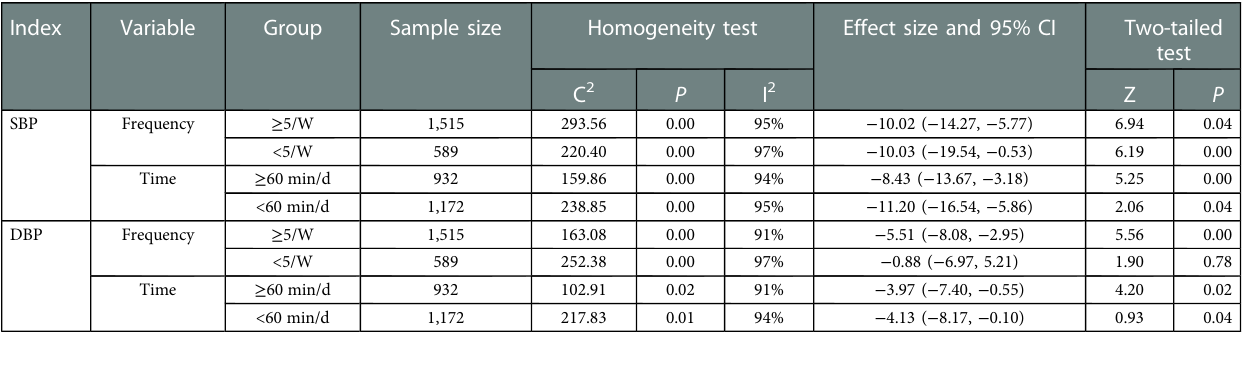
TABLE 3 The subgroup analysis of lipid